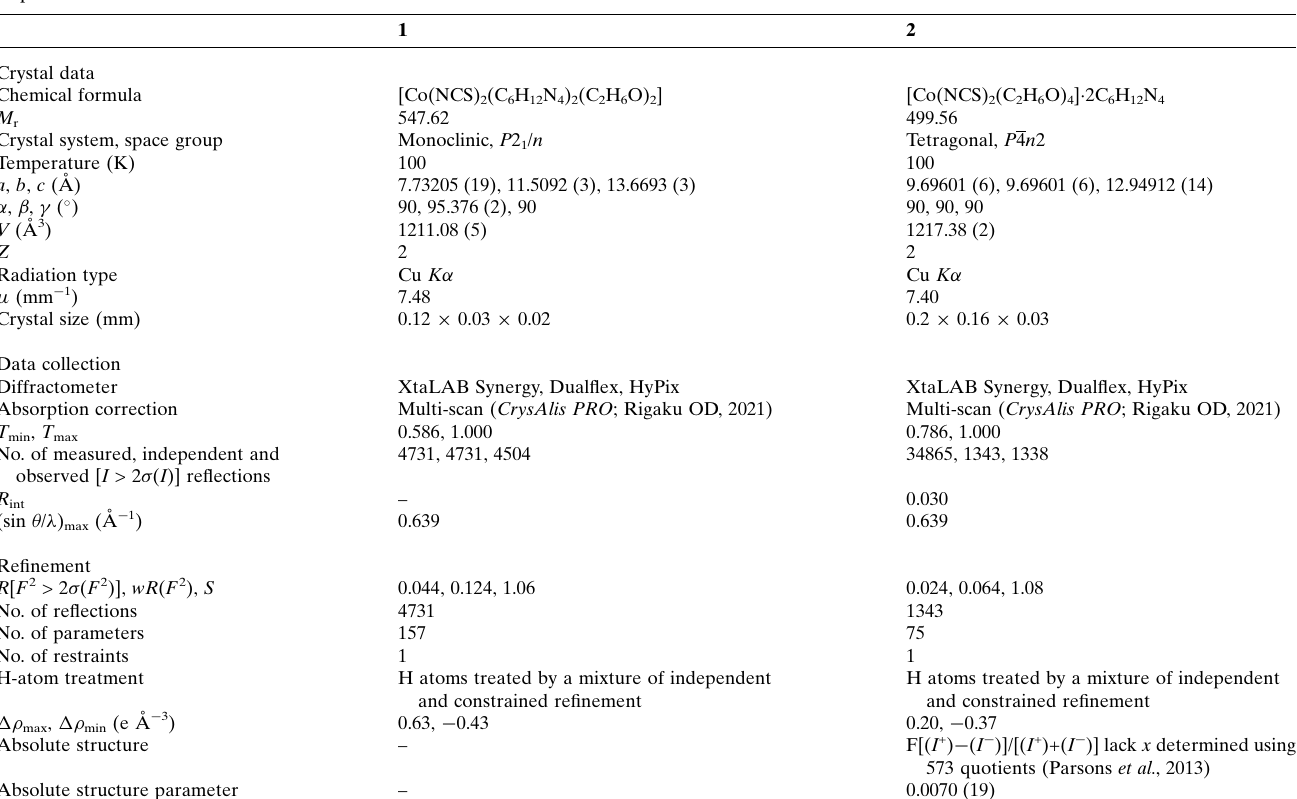
Table 5 Experimental details.